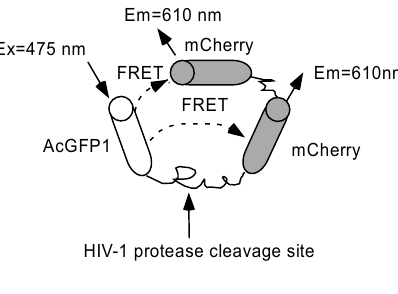
Figure 1. The schematic diagram of the FRET probe consists of tandem acceptors that function to enhance the absorption of energy resonance transferred from the donor. The donor AcGFP1 is linked with the acceptor mCherry through an HIV-1 protease cleavable peptide and the second acceptor is connected to the first acceptor.